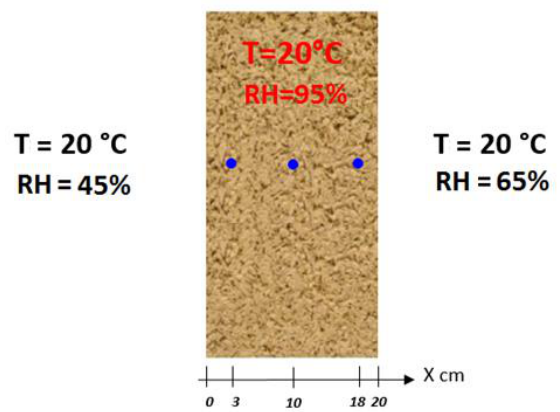
Figure 4. The international benchmark HAMSTAD WP2 study configuration [25].